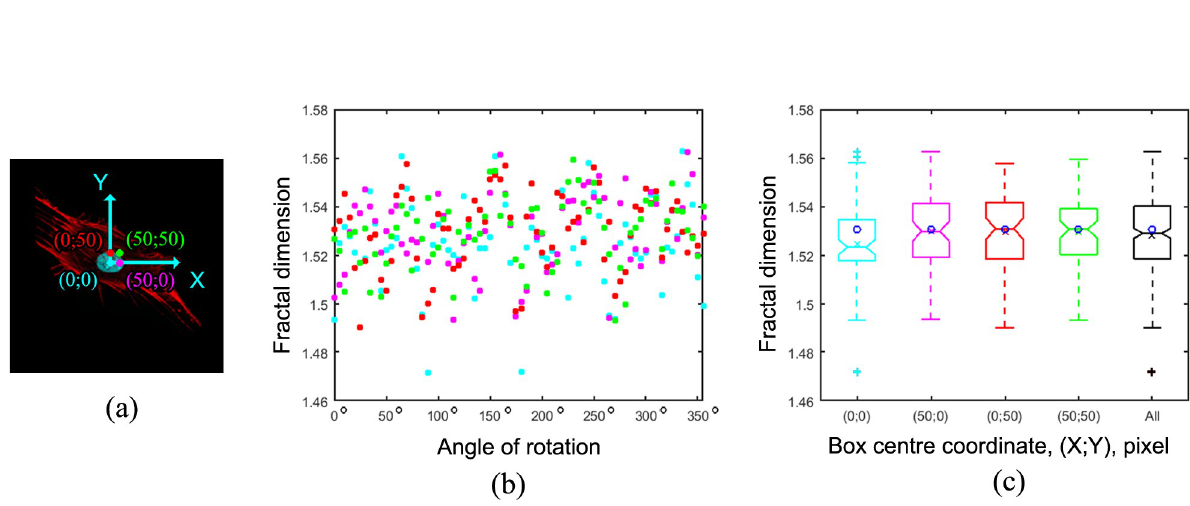
Fig 4. Distribution of fractal dimension values for F-actin image of a random cell on different angles and box positions. (a) Representative F- actin image of the cell from control group. Color points and pixel coordinates (cyan, green, red, and magenta) shows the positions of 4 box centers during box counting process. (b) dot plot shows variation of FD values which were obtained during the variation of the positioning of box centers and rotation angles. (c) notched boxplots of FD values (averaged for values obtained by varied positioning of box center and rotation angles). Black boxplot represents the cumulative FD values for all angles and box positions. Mean values are shown as color-coded crosses (x) on the boxplots. FD value (calculated using the previously described algorithm, see Methods) is shown as blue circles for comparison of the value with the medians and mean values of current FD